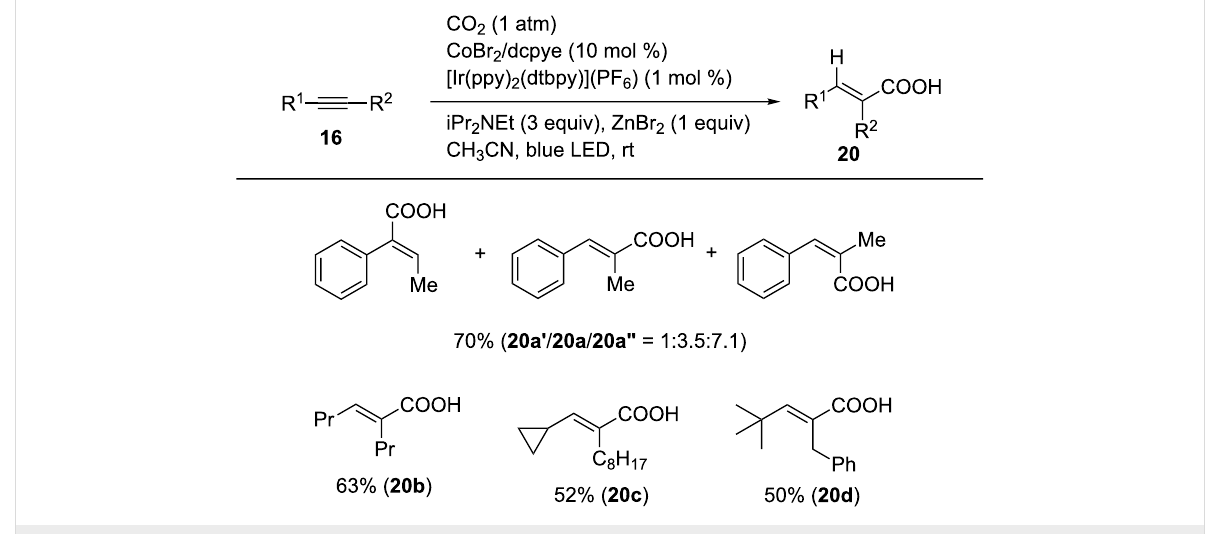
Scheme 20: Visible-light-driven hydrocarboxylation of alkynes.